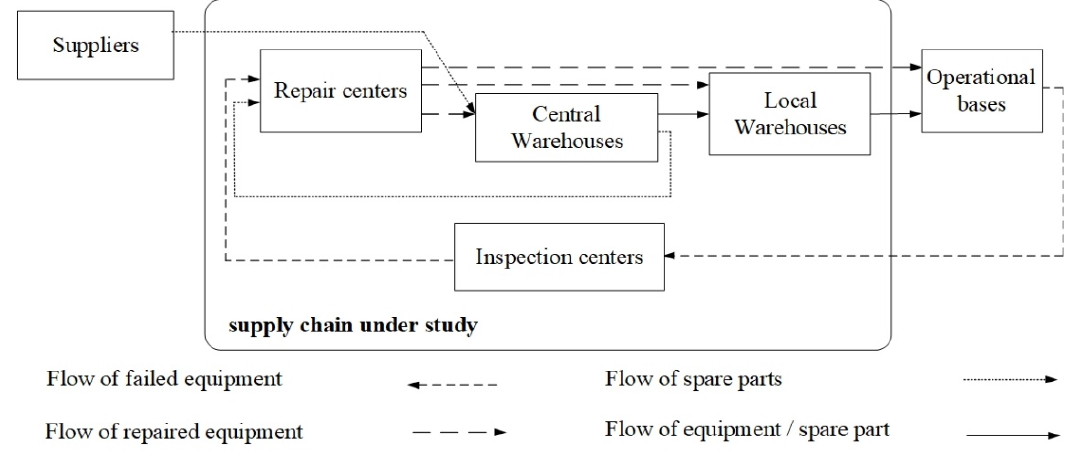
Fig. 1. Repairable spare part inventory